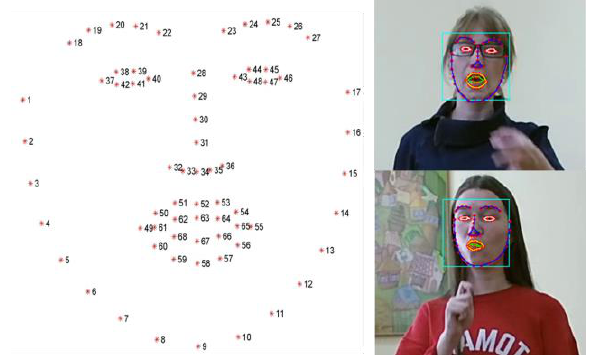
Figure 3. Full 2D face shape model (left) and the face landmarks localization algorithm results (right).